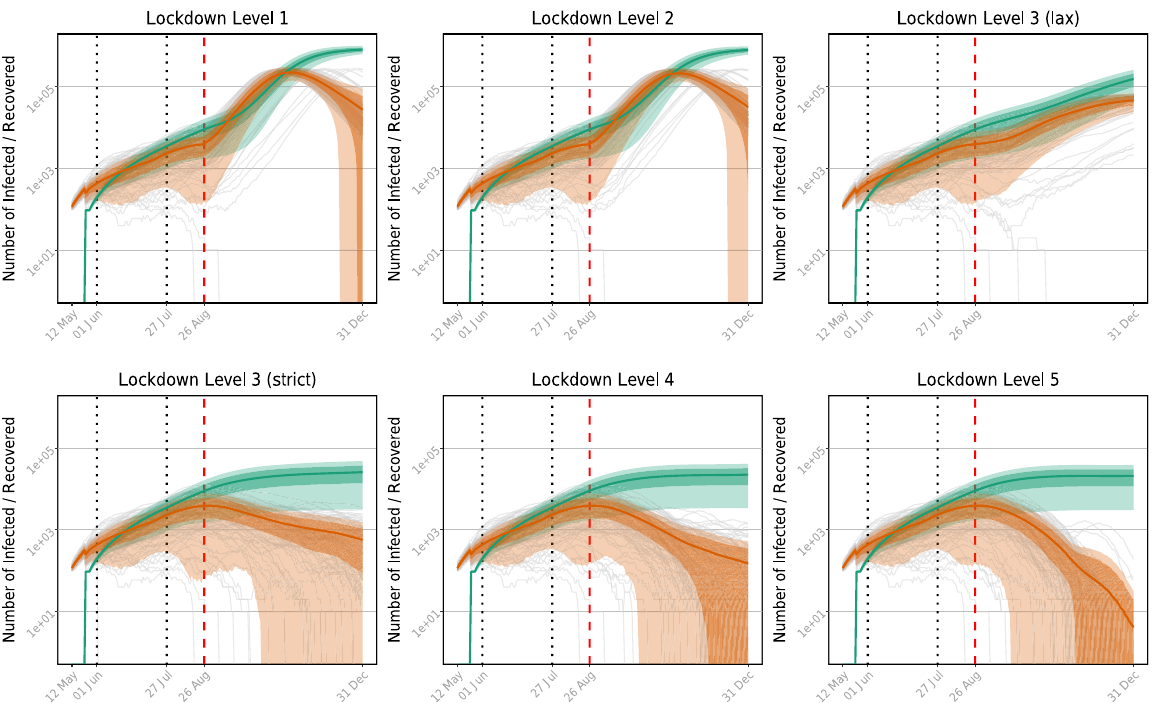
Fig. 10 Simulated infection dynamics in NMBM with an lockdown from 26 August 2020 on, the measures are continuous and are not lifted. Despite the long-run measures, the number of active case continuously increases in the simulations with the three lax lockdown levels and decrease in the strict ones. Enduring a strict level 5 lockdown until the end of the year eradicates the active infection in almost all simulations.